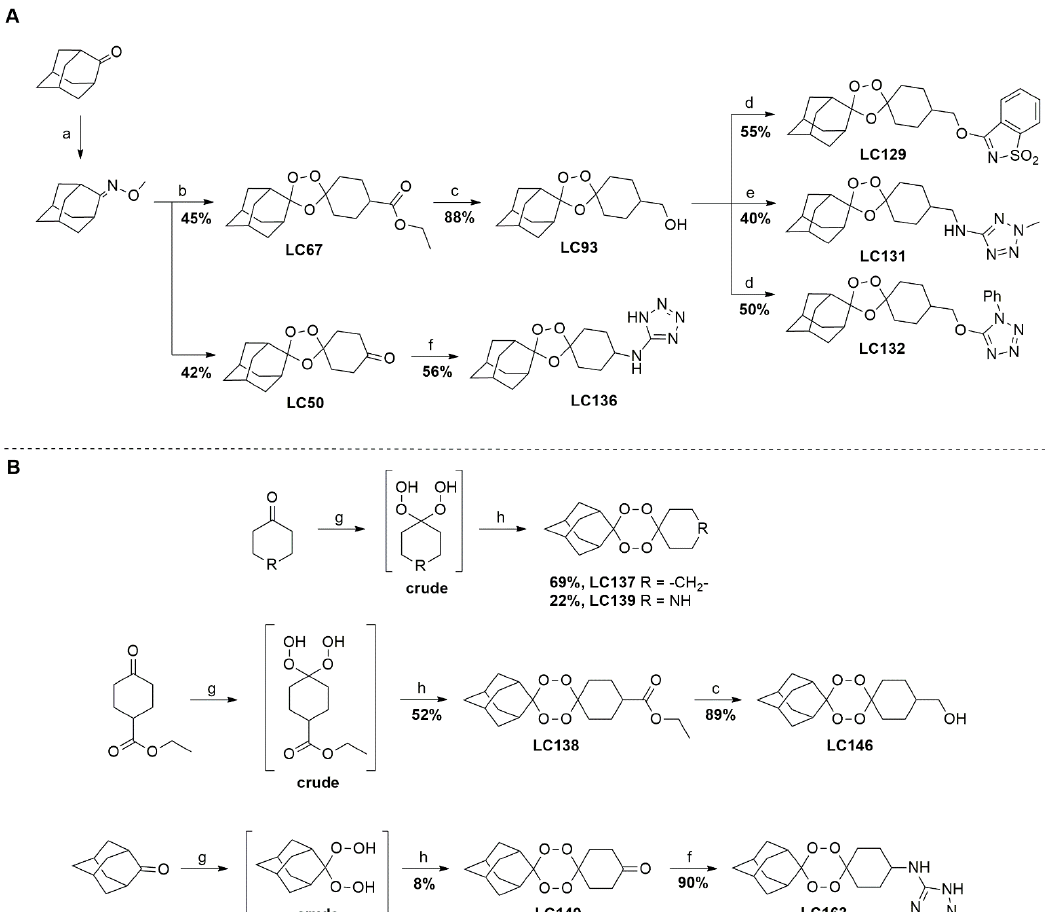
Figure 4. Synthesis and structural representation of the 1,2,4-trioxolanes and 1,2,4,5-tetraoxanes in- vestigated in this work. ( A ) Representation of the synthetic routes to the 1,2,4-trioxolanes; reagents and conditions: (a) Pyridine, MeONH 2 , MeOH, r.t; (b) ketone, O 3 , CH 2 Cl 2 /Pentane, −7 8 °C; (c) 1. LiAlH 4 , anhydrous Et 2 O, 0 °C, 1 h; 2. H 2 O; (d) Chloride derivative, TEA, Toluene, 45 °C; (e) 1. Triethyamine, mesyl chloride, THF, 3 h, 2. Amine, 60 °C; (f) Amine, AcOH, DCE, NaBH(OAc) 3 , r.t.; ( B ) Representation of the synthetic routes to 1,2,4,5-tetraoxanes; reagents and conditions: (g) SSA, CH 3 CN, H 2 O 2 50% ( w/w ), 0 °C-rt; h) Ketone, SSA (2 eq), anhydrous CH 2 Cl 2 , rt, 2